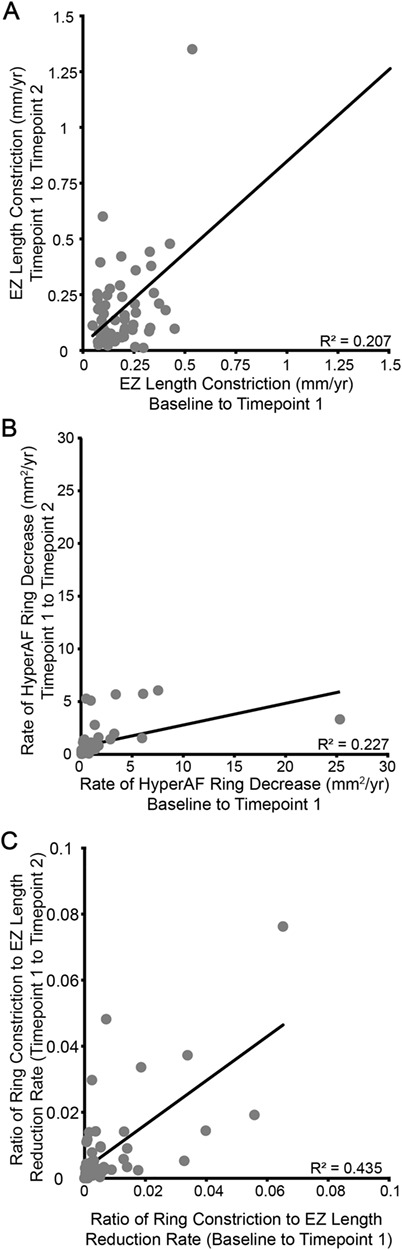
Inter-relatedness of progression between metrics. While there is a strong correlation between the rate of change observed in the first and second observation periods for both EZ length constriction (A) and hyperautofluorescence (hyperAF) ring constriction (B), neither correlation line describes the data well (r2 = 0.207 and 0.227 respectively). The ratio of EZ length and hyperAF ring constriction accounts for a much greater share of the variability (C, r2 = 0.4355).